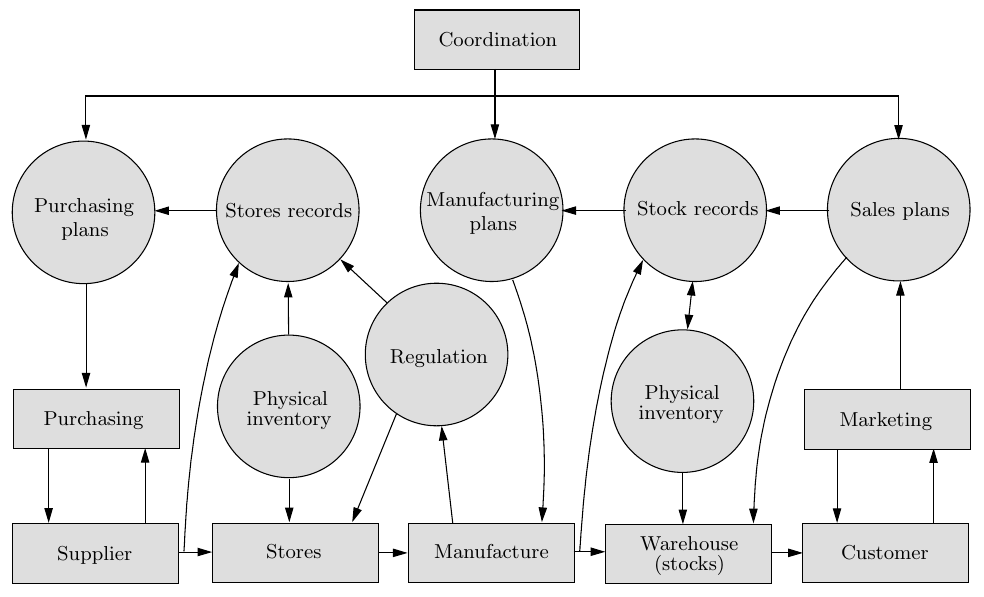
Internal coordination on the operational/tactical level and connections to suppliers and customers (Ericsson 1974).